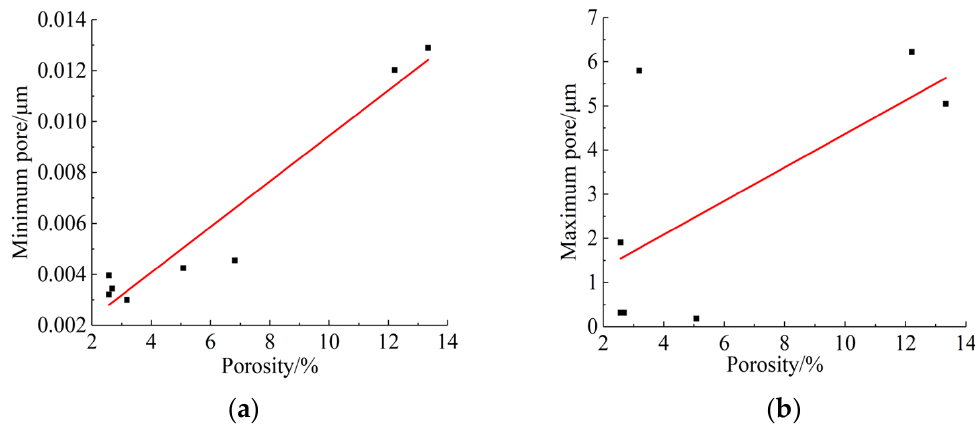
Figure 13. The relationship between porosity and pore threshold. ( a ) The minimum pore size; ( b ) the maximum pore size.